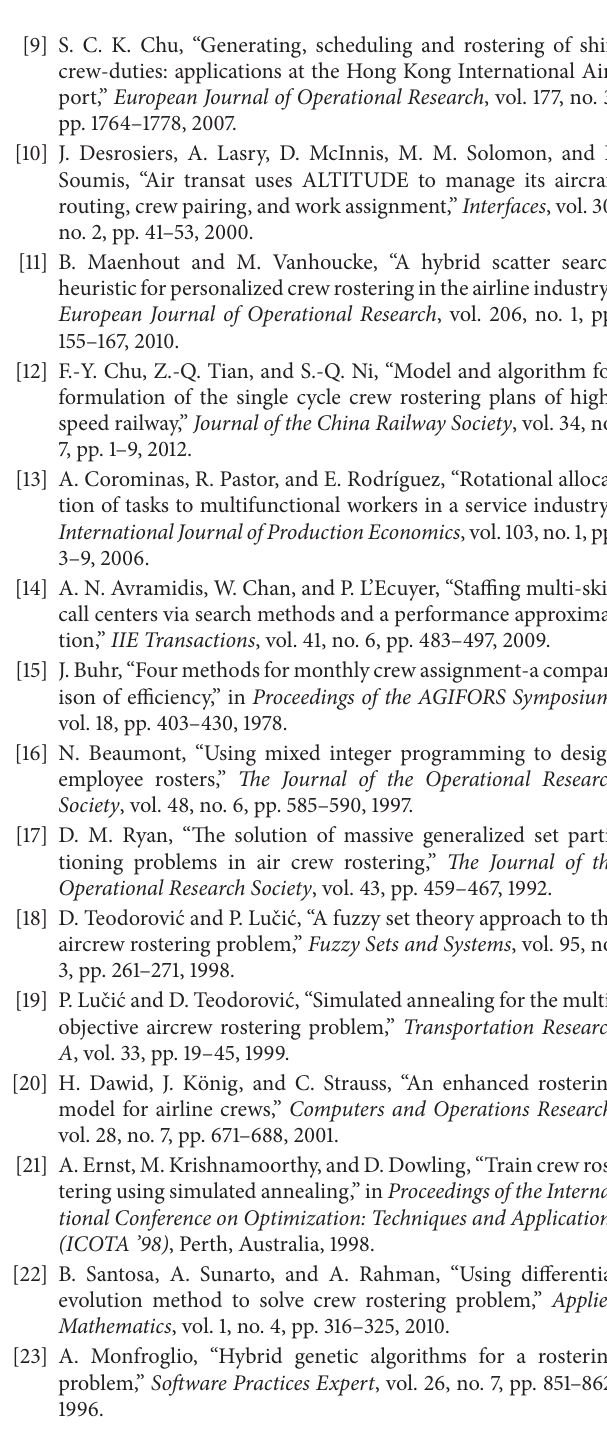
Table 5: Optimal crew rostering plan with 𝑇 = 28 and 𝑇